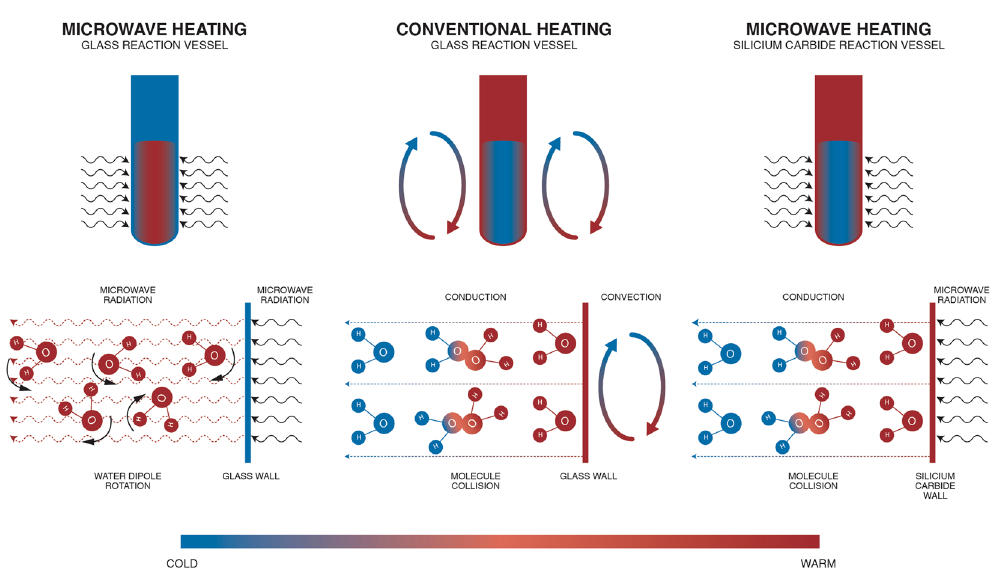
Figure 2. Overview of different heating